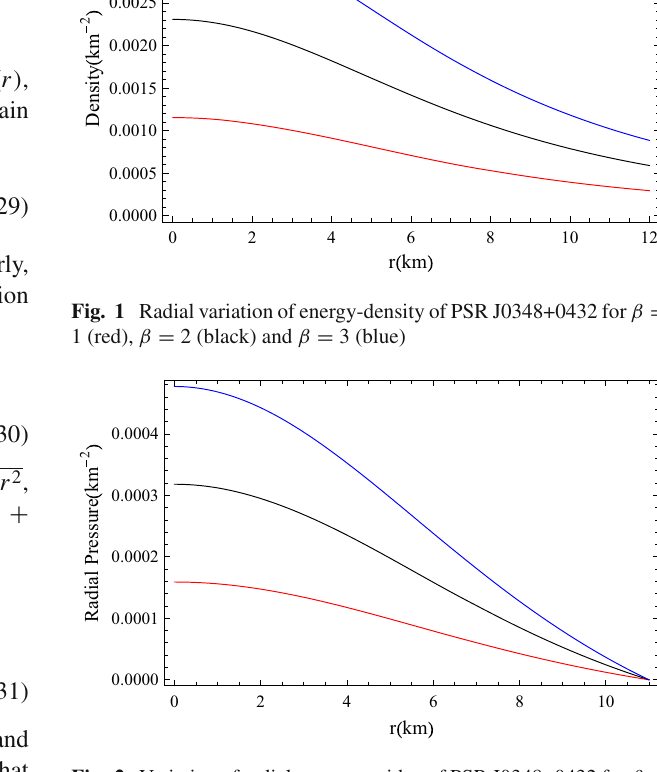
Fig. 2 Variation of radial pressure with r of PSR J0348+0432 for β = 1 (red), β = 2 (black) and β = 3 (blue) (considering α = 0 . 4)